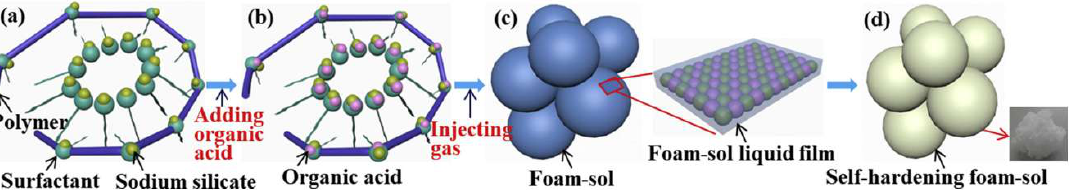
Figure 10. Chemical mechanism for the formation of self-hardening foam sol [43].